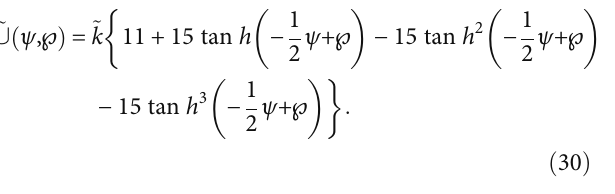
Figure 1 represents the three-dimensional upper and lower fuzzy branch plots of the approximate series result and the di ff erent fractional order of ς . Figure 2 represents the two- dimensional upper and lower fuzzy branch plots of the approximate series result and the di ff erent fractional order of ς